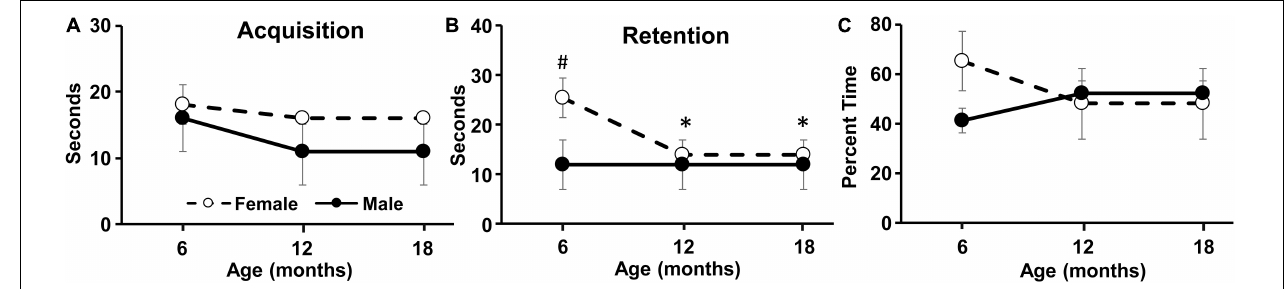
FIGURE 4 | Longitudinal change in the novel location task. The graphs indicate the time spent exploring the objects during the (A) acquisition phase, (B) retention phase, and (C) the percent time exploring the object in the novel location during retention testing. Pound sign indicates a significant ( p < 0.05) sex difference. Asterisks indicated a significant ( p < 0.05) difference from 6 months for females.